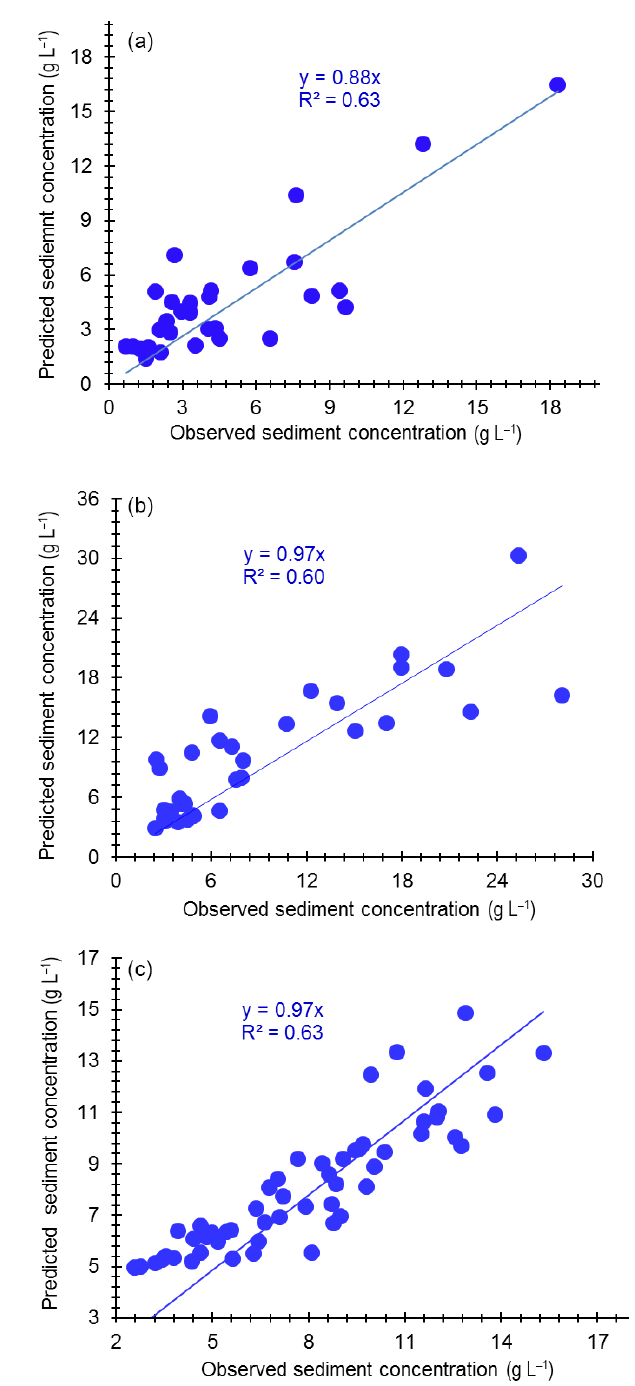
Figure 6. Predicted and observed sediment concentration using concentration rating curve for the 100ha watersheds (a) Maybar, (b) Debre Mawi and (c)